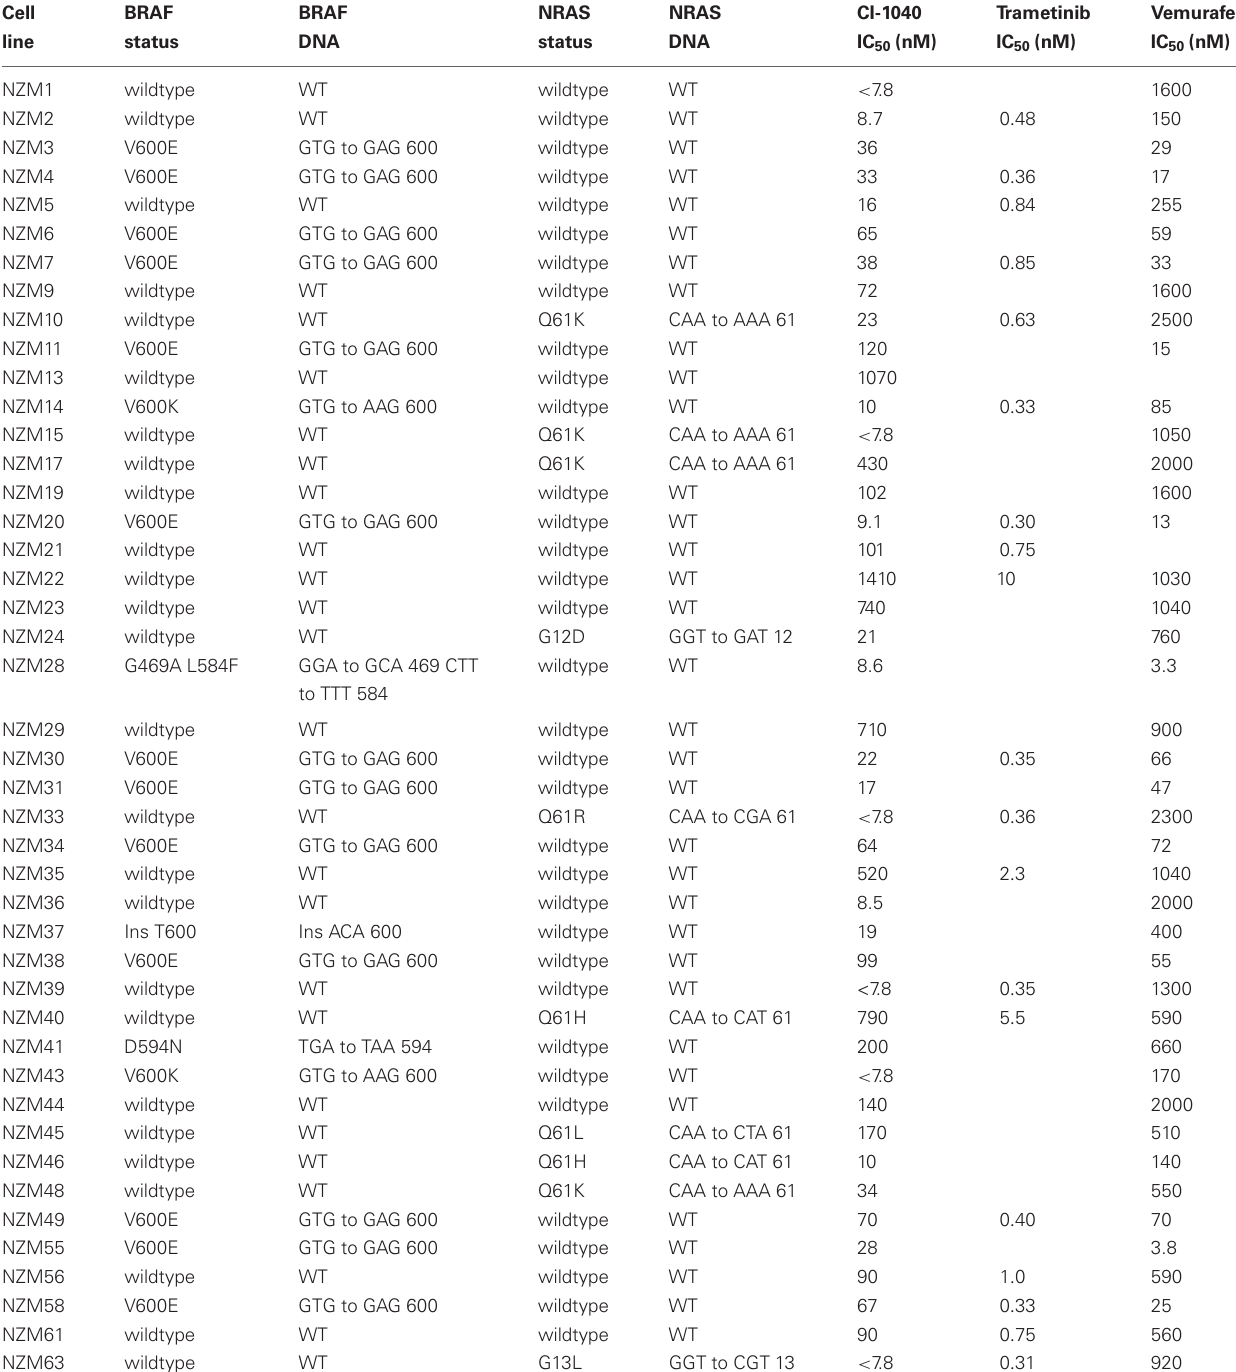
Table 2 | Genetic and IC 50 data for NZM cell lines.